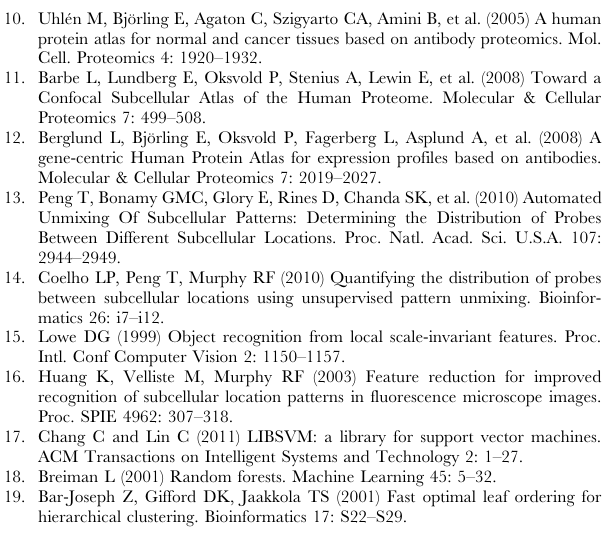
Table S3. List of proteins reannotated after second round. Table S4 Classification results using Random Forest classifier after second round of